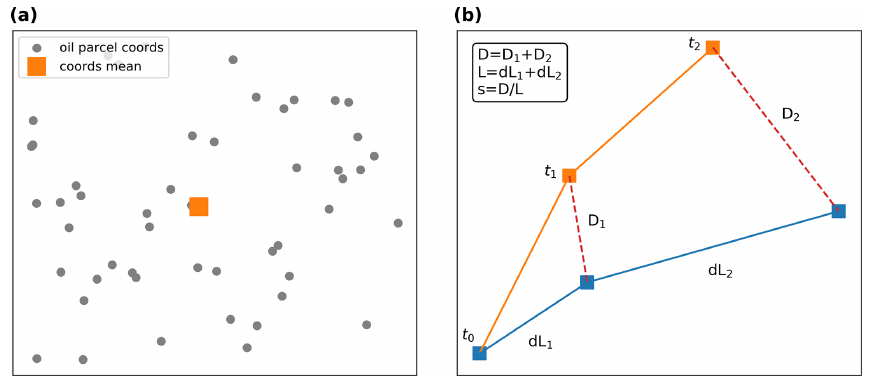
Figure 6. Schematic of (a) spatially weighted mean (orange square) of oil spill particles (gray dots), (b) mean oil spill trajectories (following the geographically weighted mean) between the deterministic (blue line) and an individual member of the ensemble (orange line), and their corresponding distances (red dashed lines) evolving over